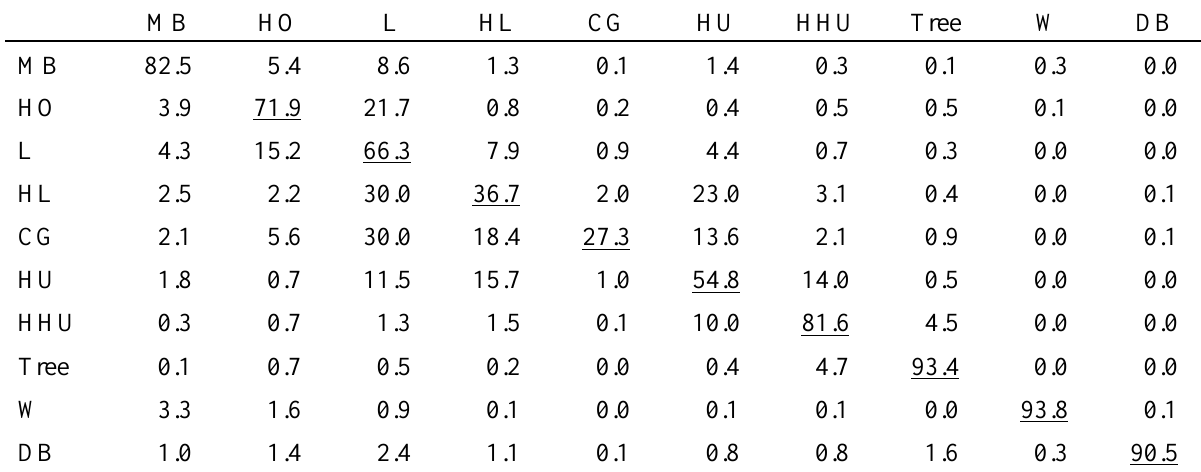
Table 12. Neighbourhood relations between classes (%). For example, 36.7 % of the 3 × 3-neighbourhood pixels of high lawn (HL) pixels belong to the same class, while 23 % belong to hummock (HU). DB = white wooden duckboard (see Figure 14; manually delineated). All cells are